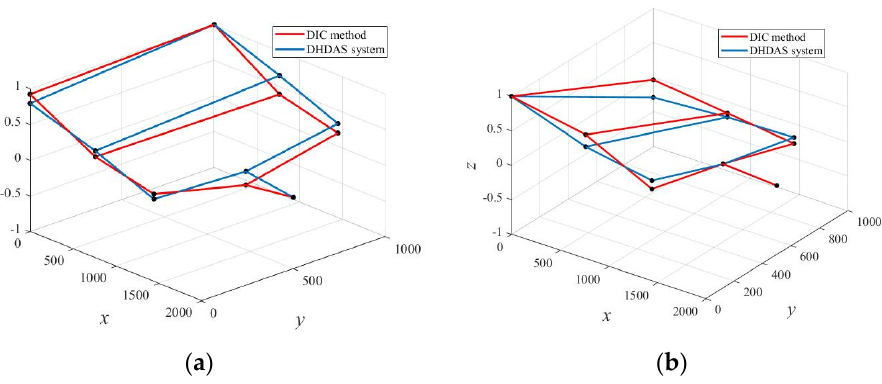
Figure 6. Mode shape diagram. ( a ) The first order mode shape. ( b ) The second order mode shape.